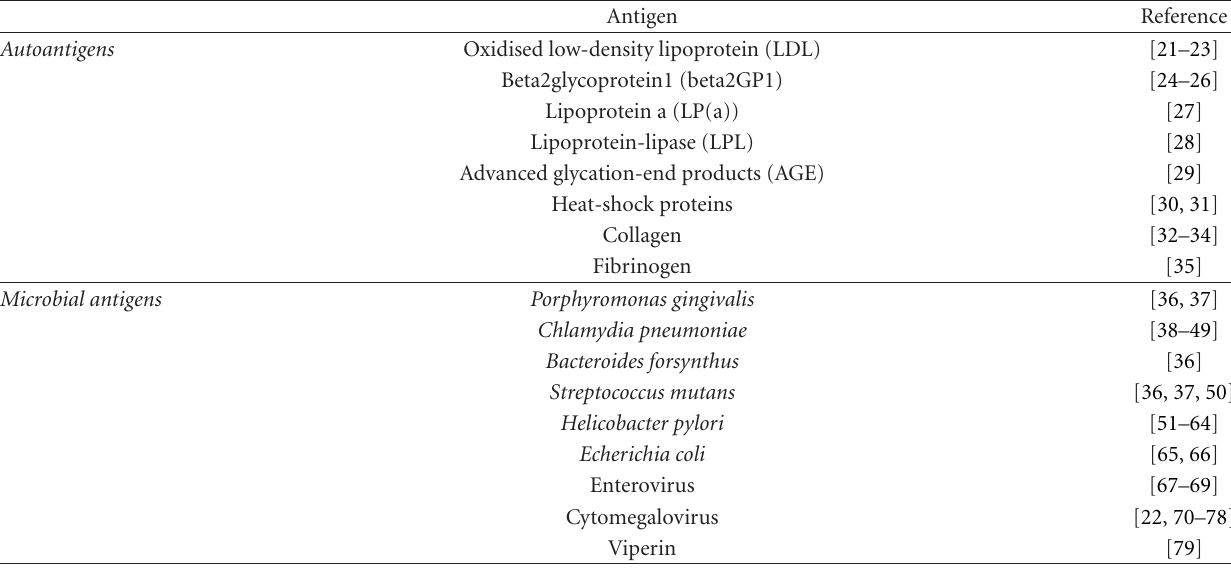
Table 1: Antigens that have been reported to be involved in